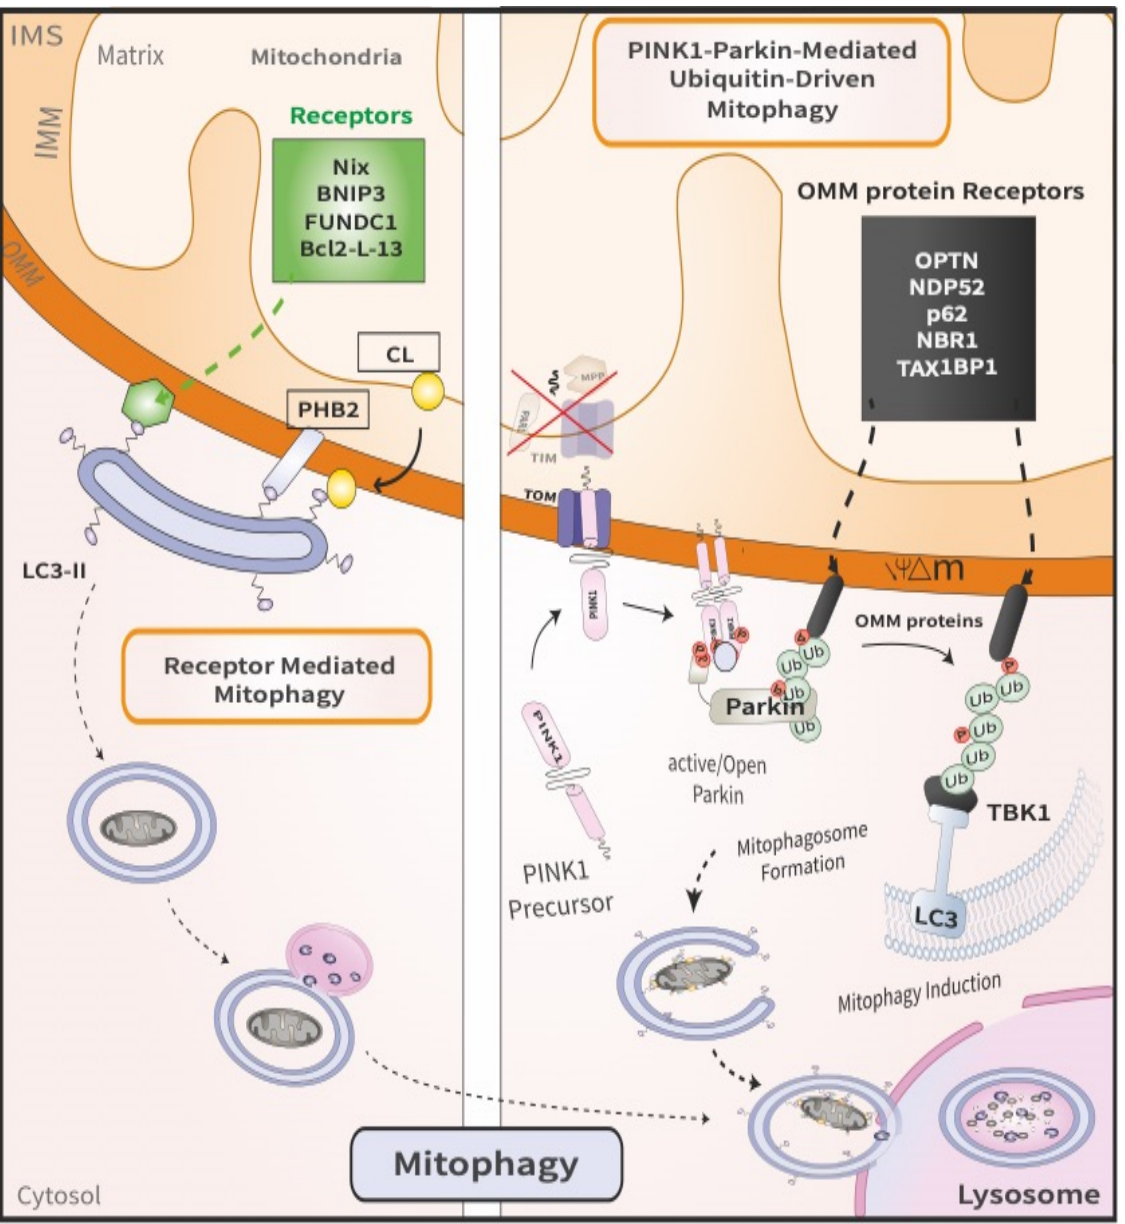
Figure 2. Comparison between PINK1/Parkin-mediated mitophagy and receptor-mediated mitophagy. The latter (left) involves the direct binding of mitophagy receptors to LC3 on the autophagosomes, which then deliver the engulfed damaged mitochondria to the lysosome. By contrast, the former ( right ) is a multi-step process that ensues following the loss of mitochondrial membrane potential. First, PINK1 is stabilized on the OMM of damaged mitochondria. Following dimerization, PINK1 recruits and phosphorylates Parkin, thereby initiating